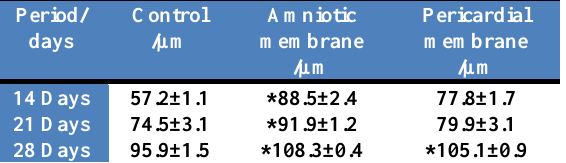
Table, 2: Shows the epithelial heights in control, amniotic and pericardial membrane groups during periods of